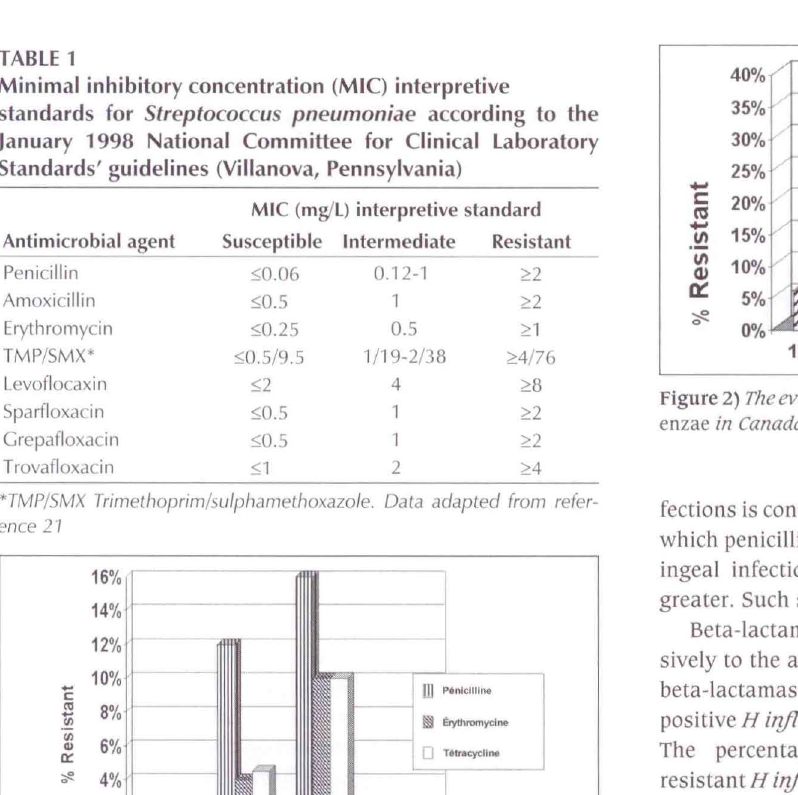
Figure 1) The evolution qf multidrug-resistant (intem1ediate and high resistanc) Streptococcus pneumoniae in Canada. Adapted.from refer